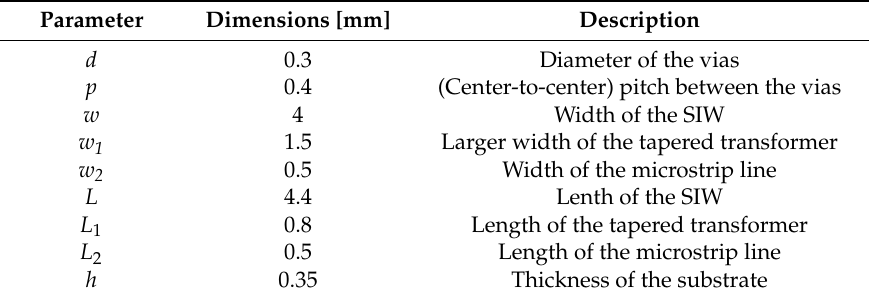
Table 1. Detailed geometric parameters of the design.